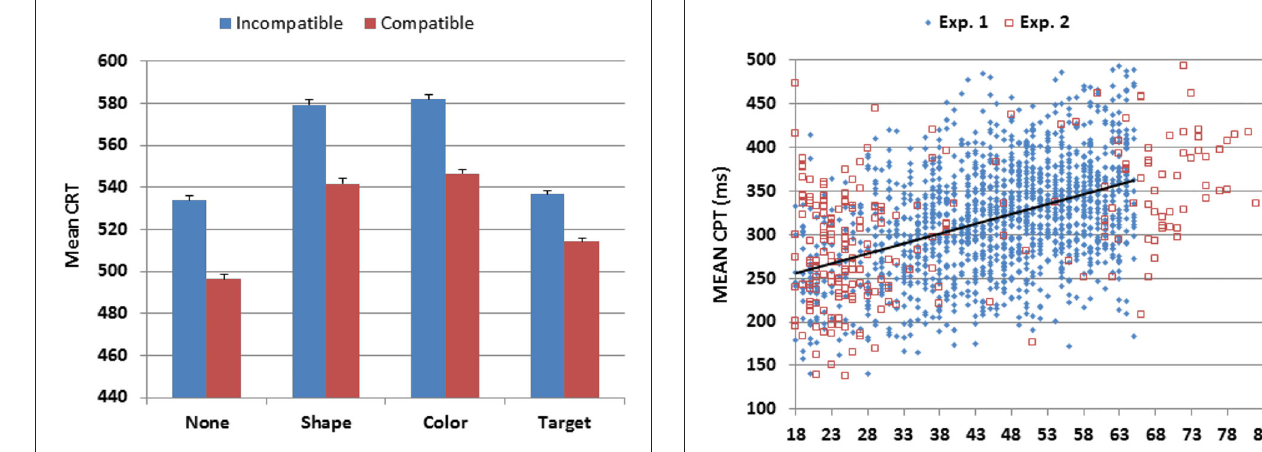
FIGURE 4 | CRTs to stimuli of different types in Experiment 1 . None = distractor with no target features. Shape = distractor with target shape. Color = distractor with target color. Compatible = stimulus delivered to the visual field ipsilateral to response button. Incompatible = stimulus delivered to the visual field contralateral to the response button. Error bars show 95% confidence intervals.